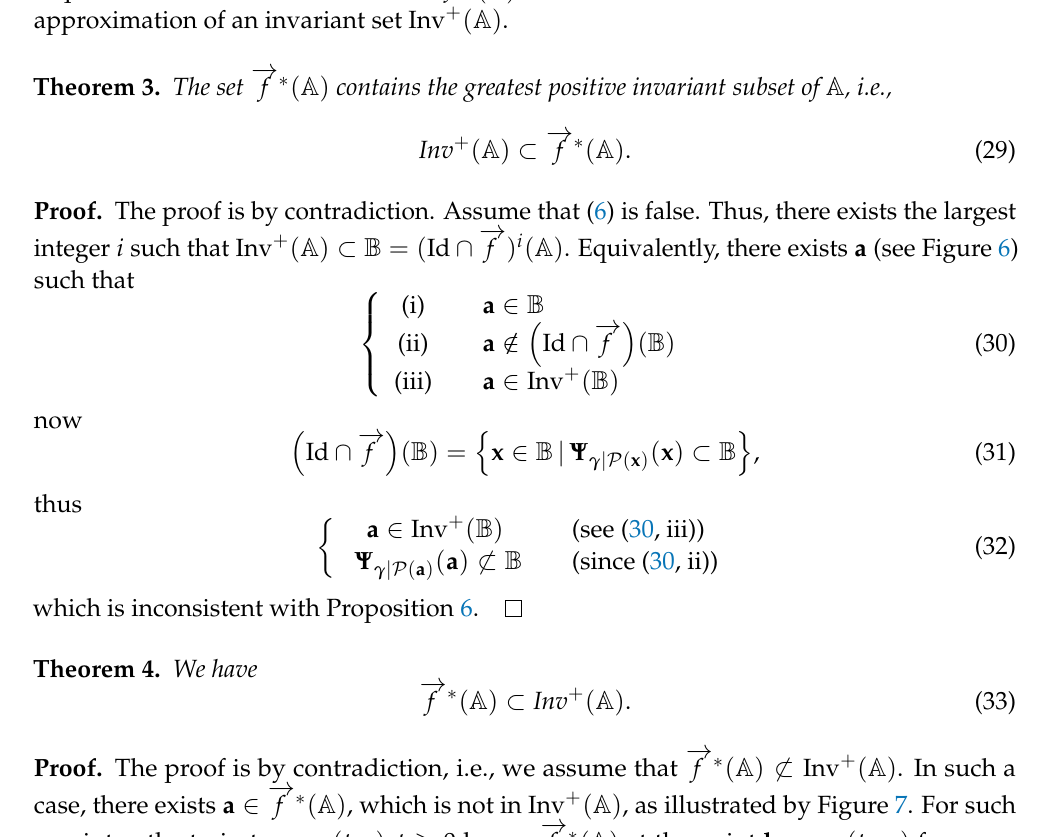
Figure 5. Forward Eulerian predictor